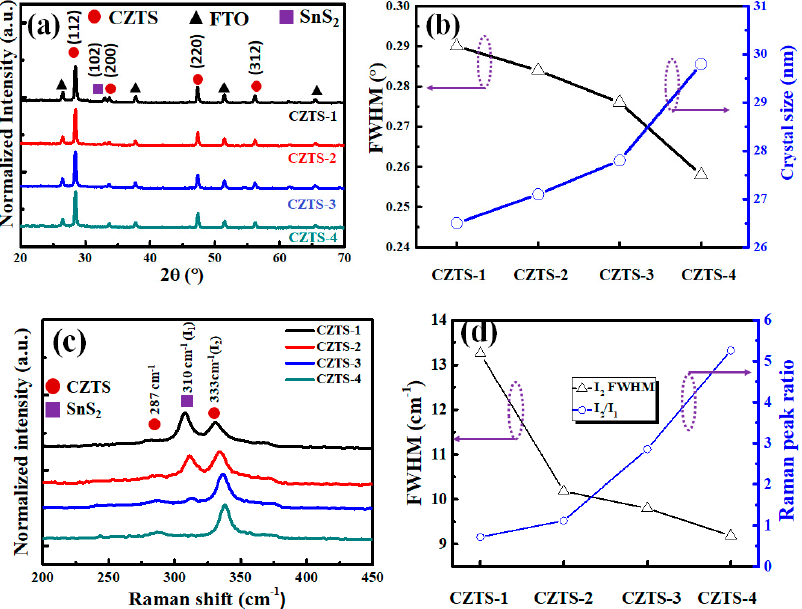
Figure 3. ( a ) XRD measurements, ( b ) FWHM and crystal size as a function of the number of precursor stacks for the (112) plane obtained by the XRD measurements, ( c ) Raman spectra, and ( d ) Raman [I 2 ] FWHM values, and Raman [I 2 ]/[I 1 ] band intensity ratio as a function of the number of precursor stacks of CZTS − 1, CZTS − 2, CZTS − 3, and CZTS − 4.